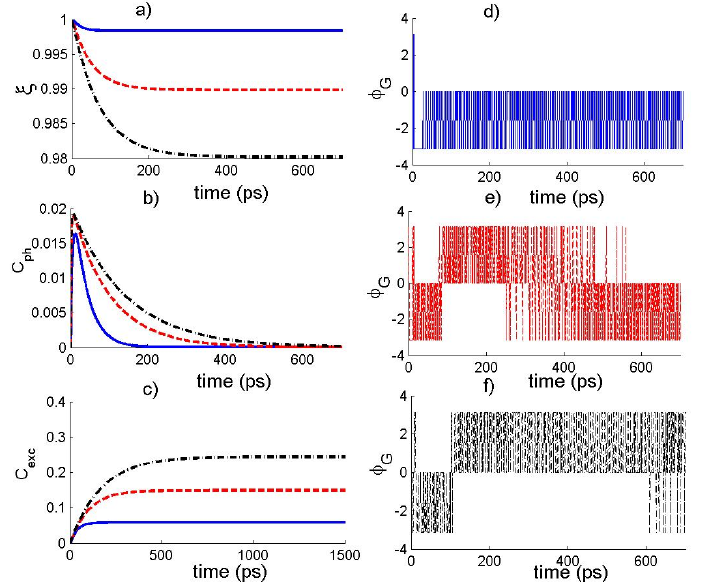
Figure 2. The temporal behavior of ( a ) state fidelity ξ ( t ) , ( b ) photons-state coherence C ph ( t ) , ( c ) exciton-state coherence C exc ( t ) and ( d – f ) the total phase φ G of the photon–exciton state for α = 10 − 8 , ( g , γ ) = ( 0.07,0 ) , ε = 0.01 κ , where κ = 0.2 (solid curve), κ = 0.5 (dashed curve), and κ = 0.8 (dash-dotted curve).